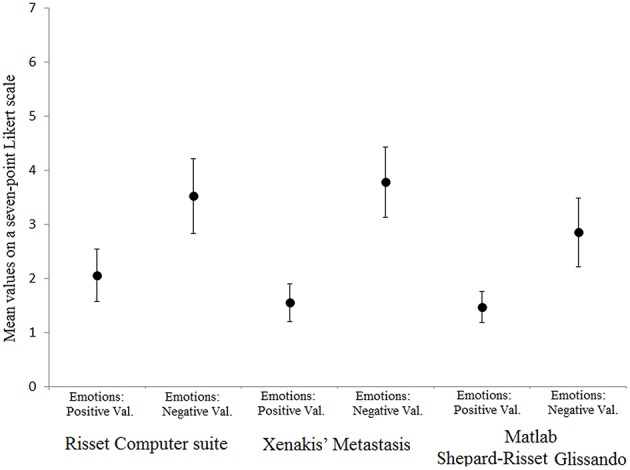
Mean values for emotions with positive and negative valence for each musical stimulus. Values are based on judgments given on a seven-point scale. Error bars represent standard deviations of the means.